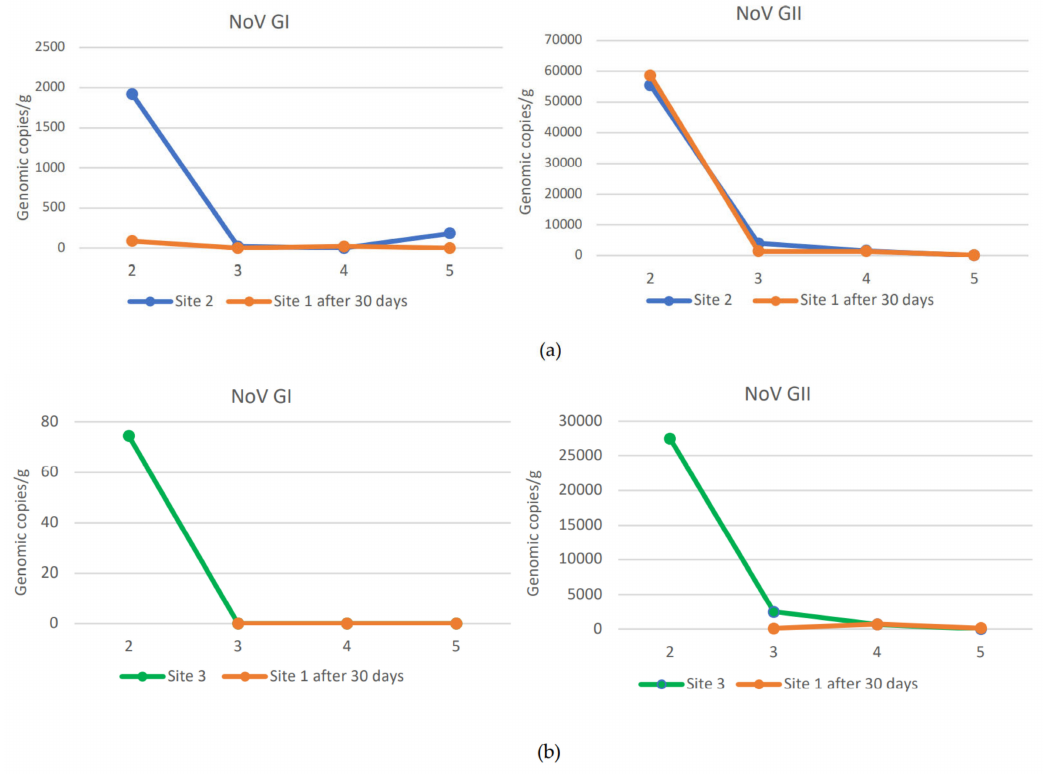
Figure 5. NoV GI and NoV GII values in oysters at site 1 after 30 days of relaying at site 2 ( a ) or site 3